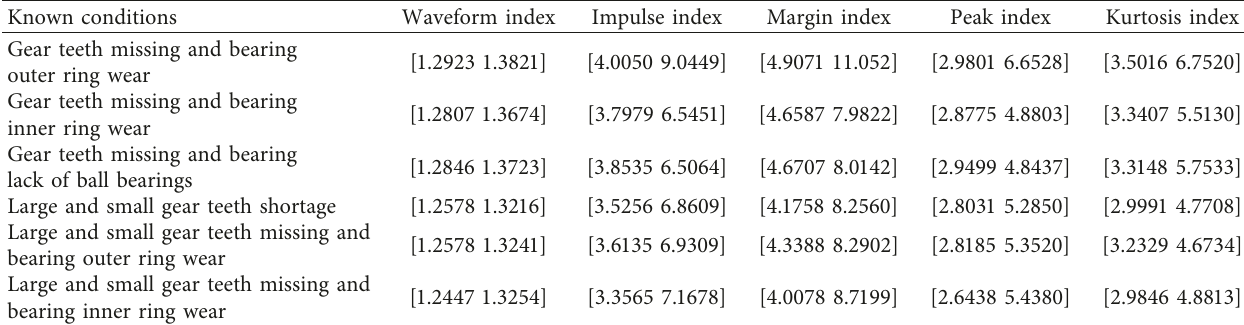
Table 3: Five dimensionless indexes of composite fault